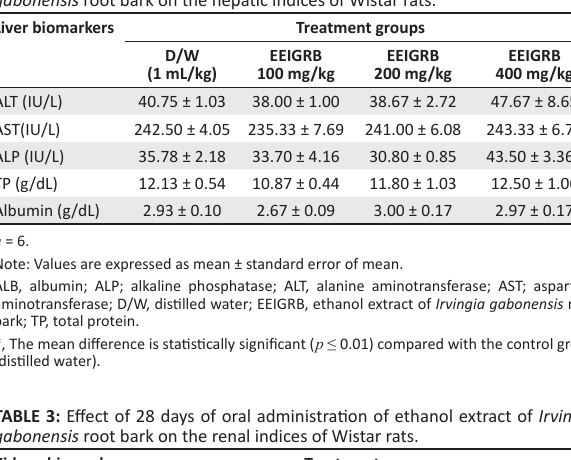
TABLE 2: Effect of 28 days of oral administration of ethanol extract of Irvingia gabonensis root bark on the hepatic indices of Wistar rats.